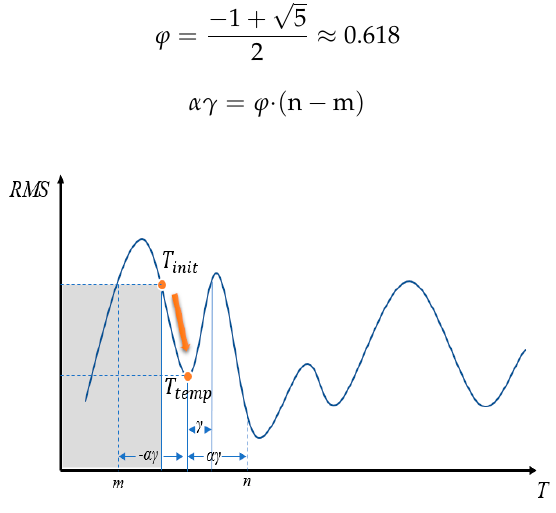
Figure 4. Example Illustration of the RMS Solution.